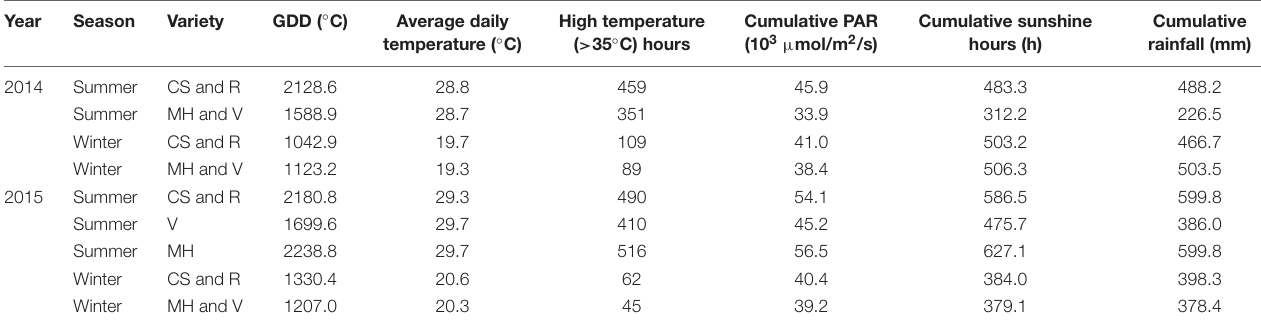
TABLE 1 | Meteorological data in 2014 and 2015 growing